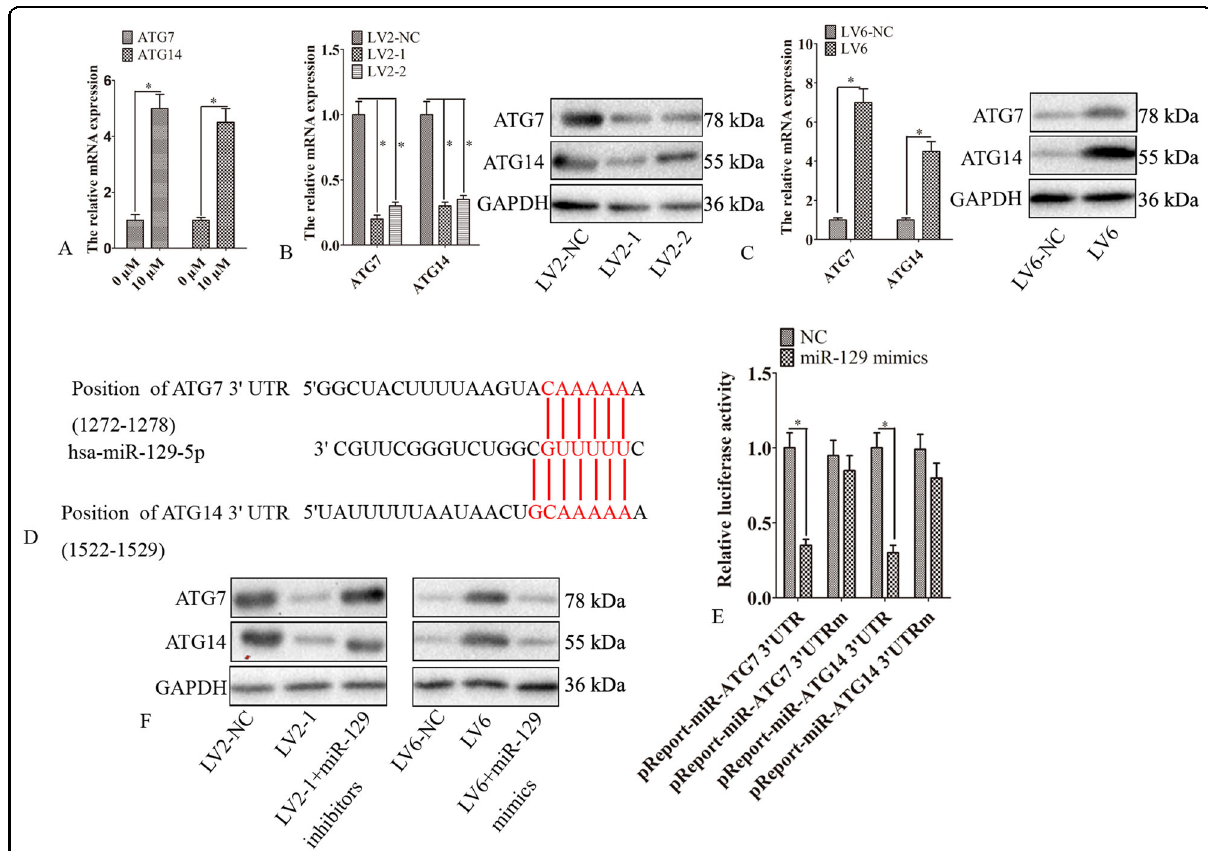
Fig. 5 CircRAB11FIP1 mediated the expression of ATG7 and ATG14 through sponging miR-129. A SKOV3 cells were subjected to 24-h Torin 1 treatment. Afterward, the mRNA expression of ATG7 and ATG14 was determined using qPCR. B LV2-1, LV2-2, or LV2-NC was transfected into SKOV3 cells. Then, the expression of ATG7 or ATG14 was examined. C LV6 or LV6-NC was transfected into A2780 cells. Later, the expression of ATG7 or ATG14 was examined. D TargetScan was employed to predict the possible binding sites among miR-129, ATG7, and ATG14. E SKOV3 cells were infected with miR-129 mimic or negative control (NC) RNA along with the mutant (pMIR-ATG7 3 ′ -UTRm and pMIR-ATG14 3 ′ -UTRm) or wild-type (pMIR-ATG7 3 ′ -UTR and pMIR-ATG14 3 ′ -UTR) luciferase reporter plasmid. The luciferase activity was detected after 24 h. F SKOV3 cells were infected with LV2-1, LV2-NC, or LV2-1 + miR-129 inhibitor. A2780 cells were infected with LV6, LV6-NC, or LV6 + miR-129 mimics. Later, the expression of ATG7 or ATG14 was examined by Western blot analysis. Error bar stands for standard error. * P < 0.05; ** P <